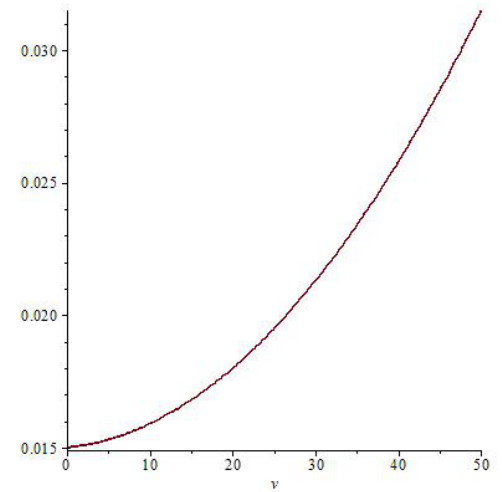
Figure 4. Increasing convex function